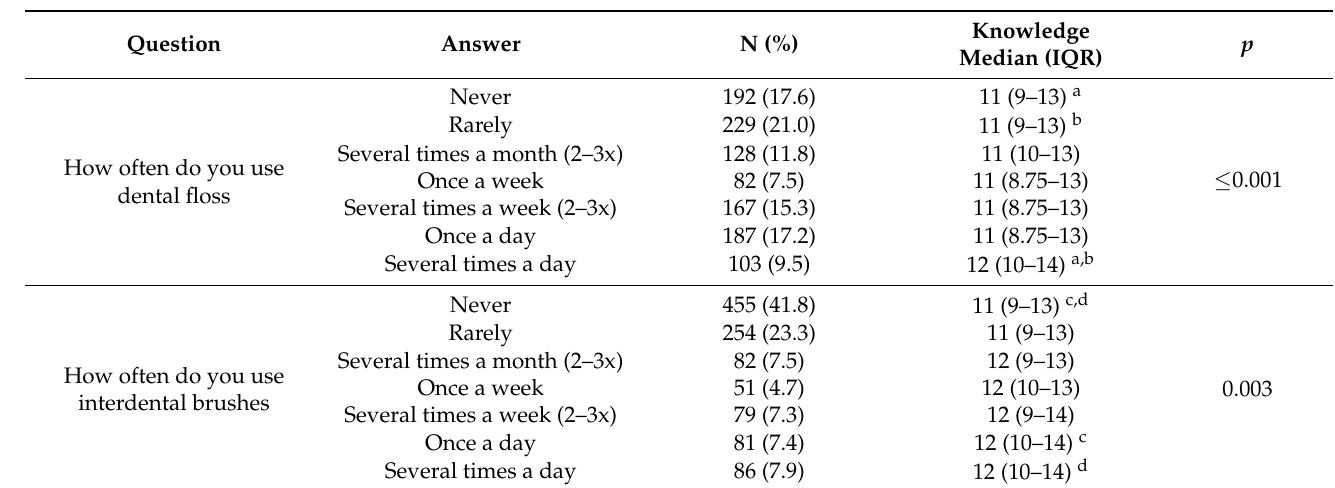
Table 4. Oral-hygienic habits–oral hygiene aids of students according to the average assessment of knowledge about oral